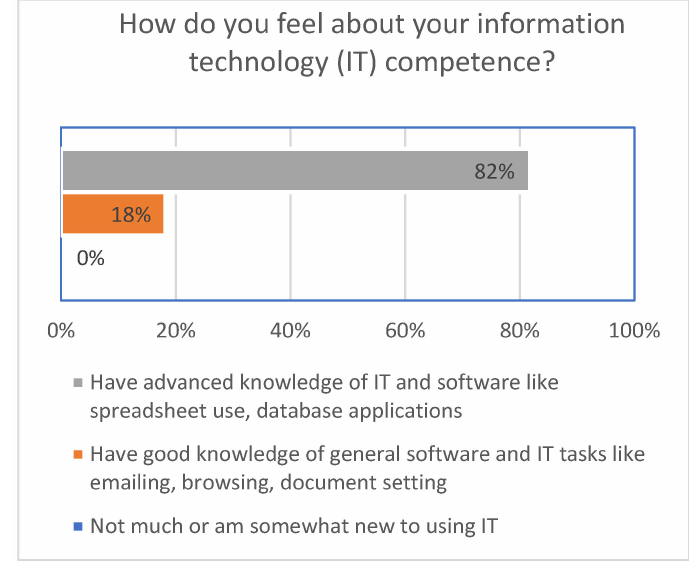
Figure 9. Respondents’ IT competence.